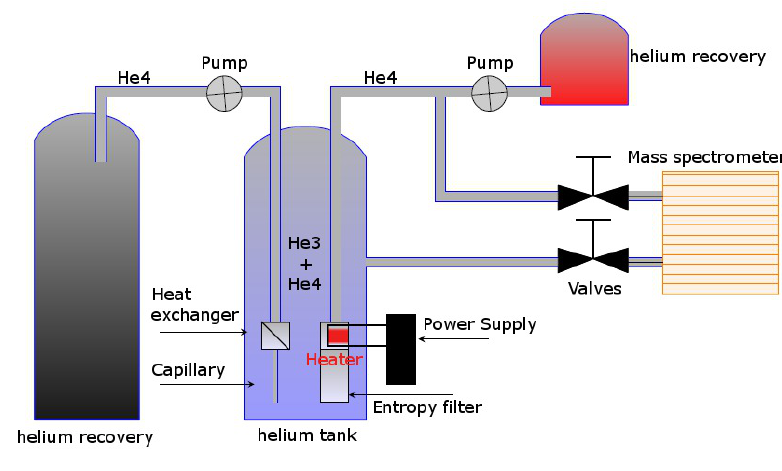
Figure 1. Diagram of the system for testing the effectiveness of entropy